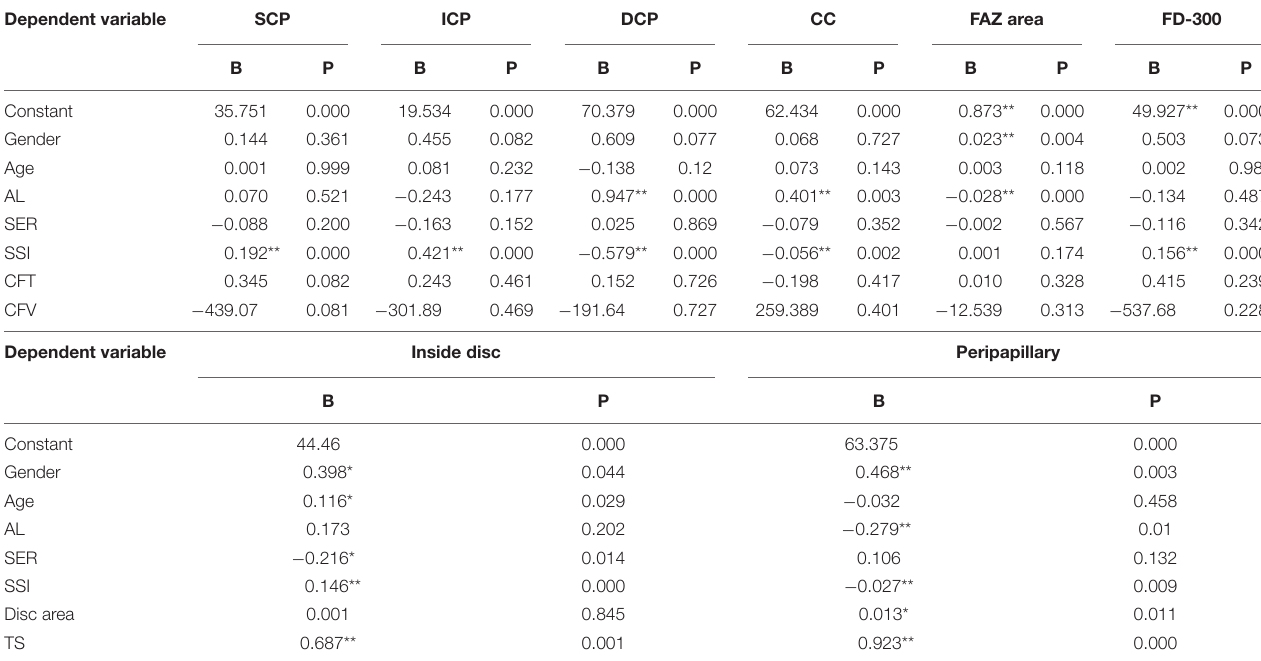
TABLE 2 | Multivariate regression analysis of factors determining a greater or lesser whole macular, inside disc, and peripapillary vascular density. Dependent